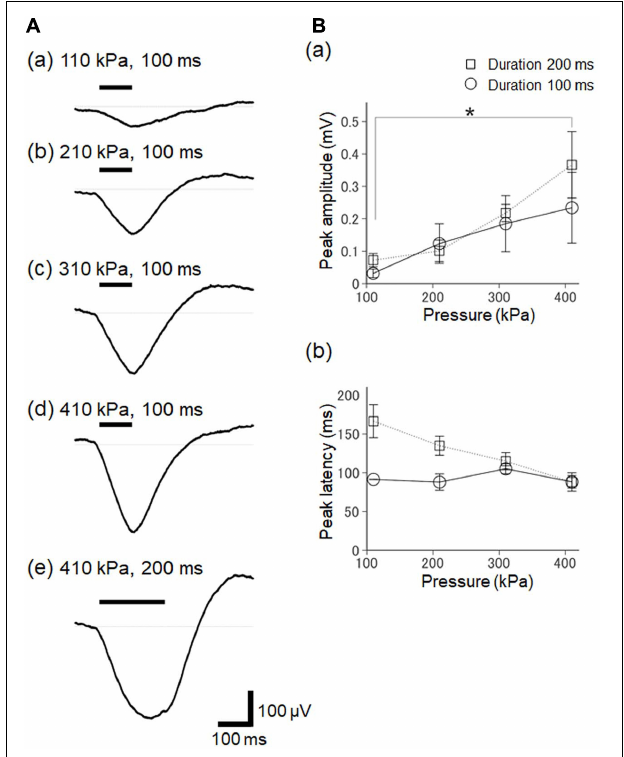
FIGURE 9 | The dependency of ultrasound-driven LFP responses on stimulation intensity and duration. (A) A typical example of elicited LFPs for various pressure and duration stimulation parameters. The values of the stimulation parameters are described in the plots. The timings of the ultrasound stimulation are illustrated by a horizontal bar on the upper left. (B) Summary of ultrasound-driven LFP response properties for different ultrasound pressures in two groups with the different durations (100 and 200 ms) of ultrasound stimulation. In (a), the relationship between peak amplitudes and stimulation pressure is illustrated for seven brain slices. In (b), similarly, the relationship between peak amplitudes and stimulation pressure is illustrated for five slices. We used the Tukey-Kramer test for multiple comparisons, * represents P <